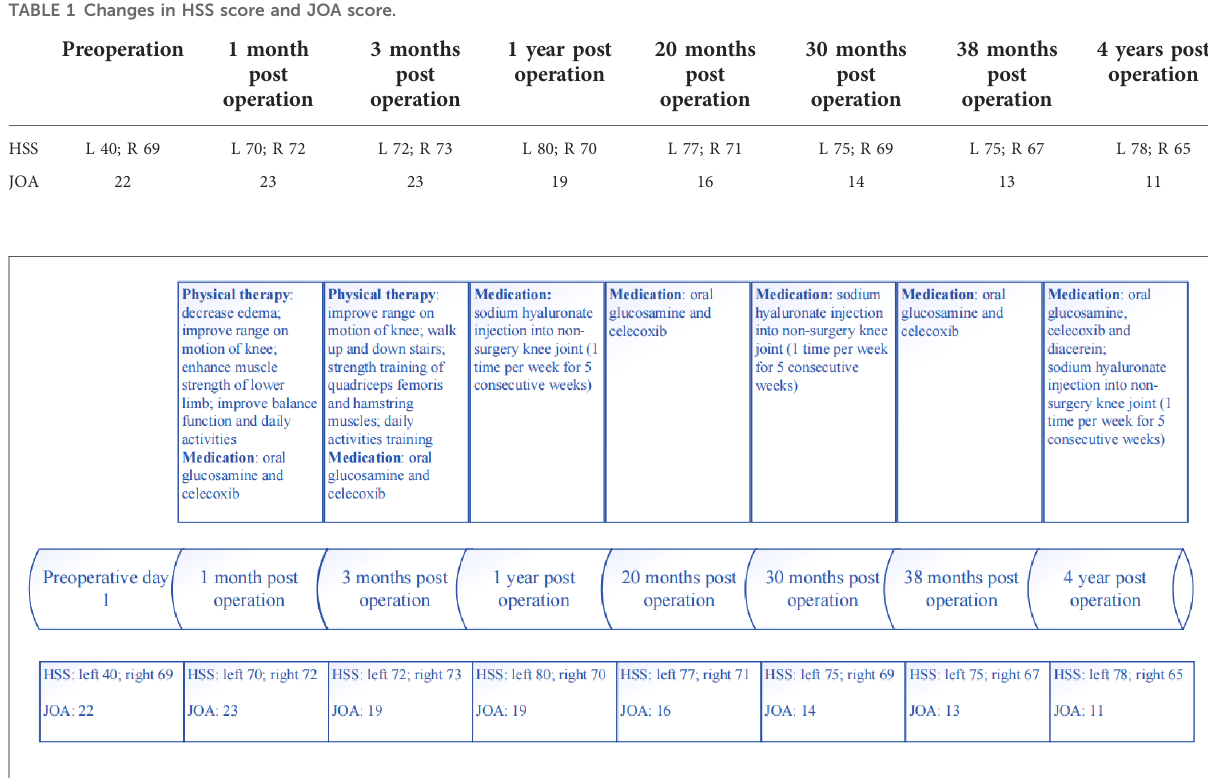
FIGURE 5 The timeline of full-process of assessment and